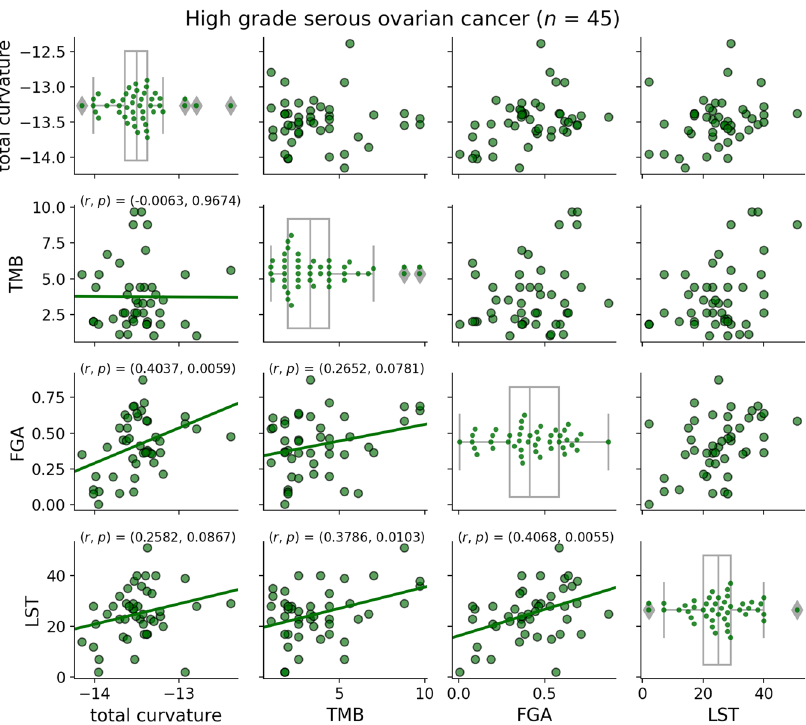
Fig. 2 Linear regression of total curvature onto clinical parameters using HGSOC samples ( n = 45). The lower triangle includes the regression line, Pearson correlation ( r ), and associated p